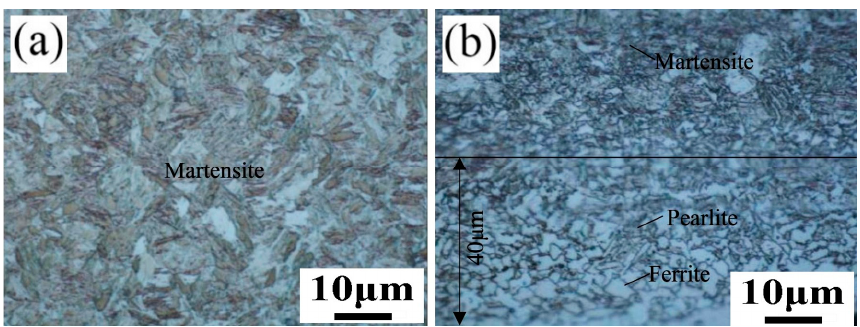
Figure 11. The decarburized layers of two investigated steels after stamping and quenching. ( a ) 22Mn3SiNb, 800 °C–5 min, ( b ) 22MnB5, 950 °C–5 min.